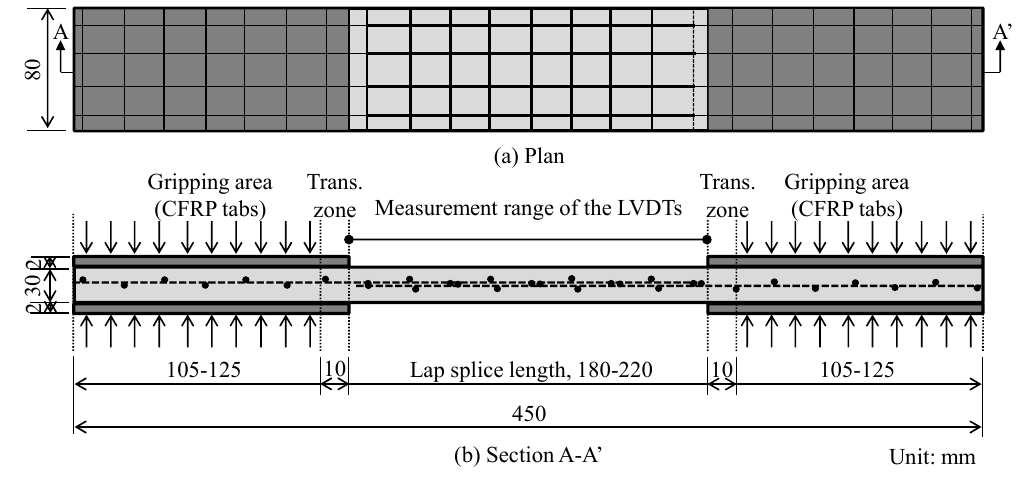
Figure 2. Details of test specimens.